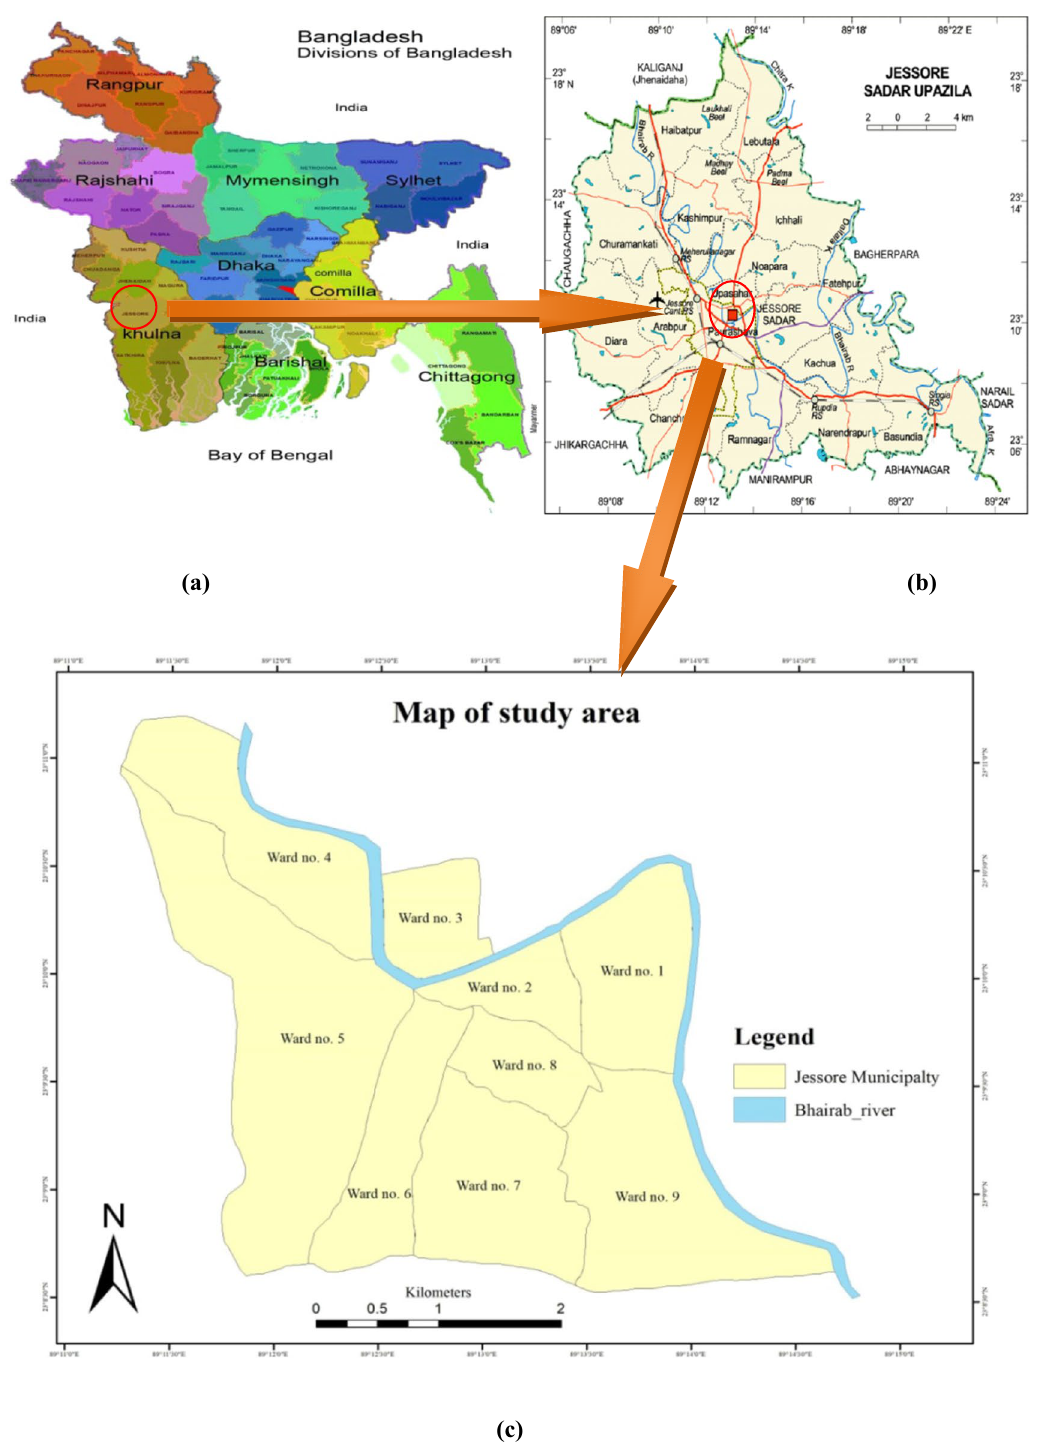
Fig. 1 Location map of the study area: a Map of Bangladesh, b Map of Jashore Sadar Upazila & c Map of the Jashore Municipality. These pho- tographs were collected from